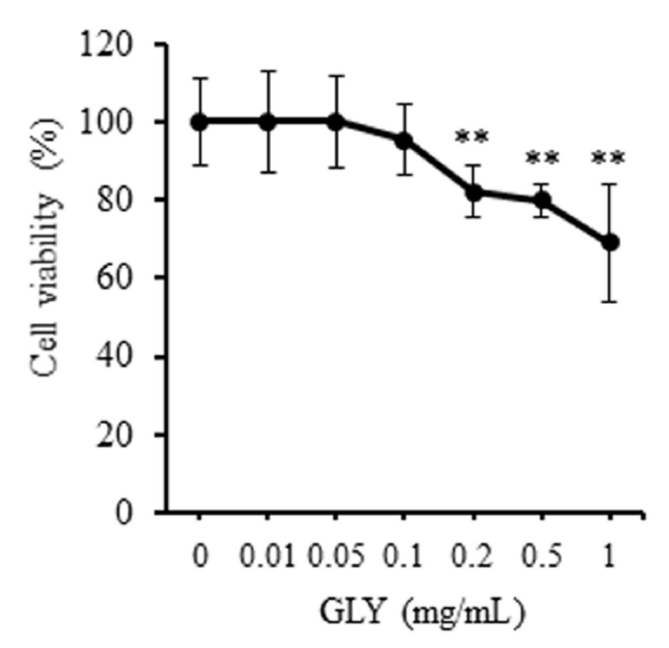
Figure 1. Effects of Gan-Lu-Yin (GLY) extracts on cell viability in RAW264.7 cells. The cells were seeded at 5000 cells/well in a 96-well plate. After sub-confluency, the cells were incubated in the absence or presence of various concentrations (0.01, 0.05, 0.1, 0.2, 0.5, and 1.0mg/mL) of GLY extracts. The cell viability was assessed for the cultivation of 48 h using Cell Counting Kit-8. The percentages of cell viability were calculated according to the values of the absence of GLY extracts as 100%. Data are presented as the mean ± SD. ** p < 0.01 compared with the cultivation with 10% fetal bovine serum (FBS) alone. These procedures were repeated two times by using triplicate RAW264.7 cell